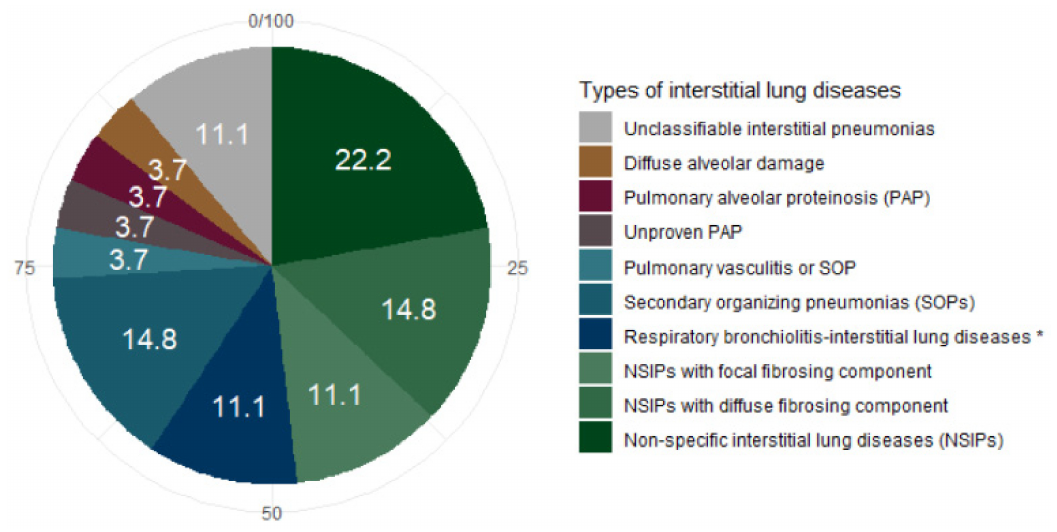
Figure 4. Pie chart of the patterns of ILDs in myelodysplastic patients. (* in non-smoking patients). The 10 cases of pleural effusion comprised chronic organizing pleuritis with exudative effusion (COPE, n = 4), pleural calcification with exudate ( n = 2), lymphocytic